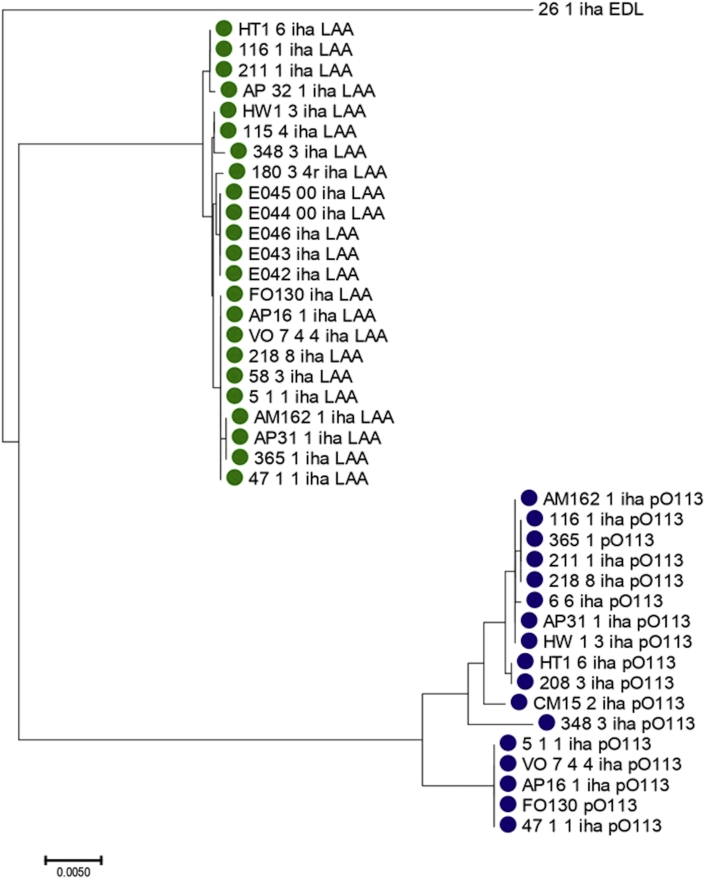
Phylogenetic tree based on iha sequences.